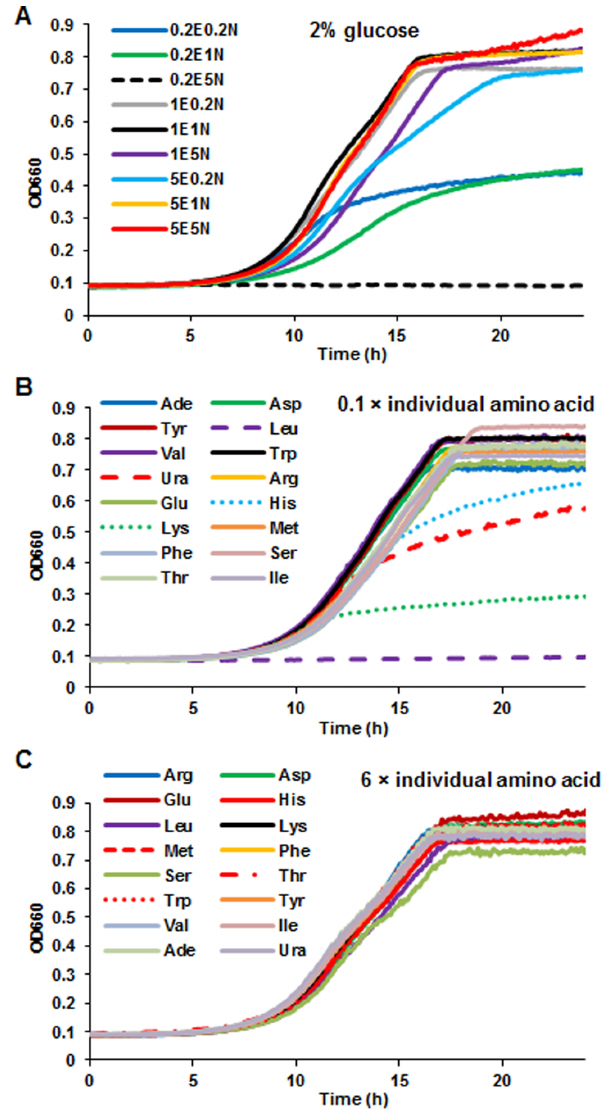
Figure 2. Growth curves of wild type yeast cultured in media with diverse amino acids compositions. ( A ) Ratio of EAA and NEAA was able to prevent yeast proliferation. ( B ) Reduction of yeast EAAs (leucine, lysine, uracil, histidine) inhibited cells growth and biomass production. ( C ) Increase of individual amino acids does not affect yeast growth. Wild type yeast (BY4742) ( < 1 6 10 4 cells) cells were grown in each well of 96-well microplate containing 100 m L of different media. The cell population was monitored with a microplate reader by recording the OD every 5 min at 660 nm. All tests were based on SD media. 1E5N represents SD medium containing 1-fold EAA and 5-fold NEAA.